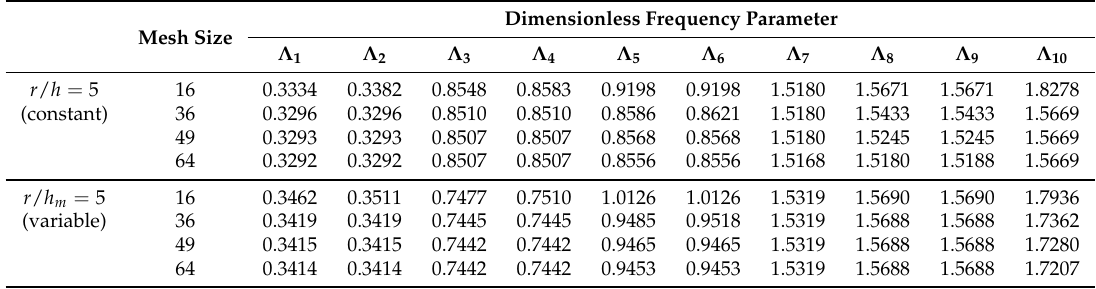
Table 3. Convergence of dimensionless parameter Λ for a truncated hemisphere with FF boundary conditions. Mesh Size